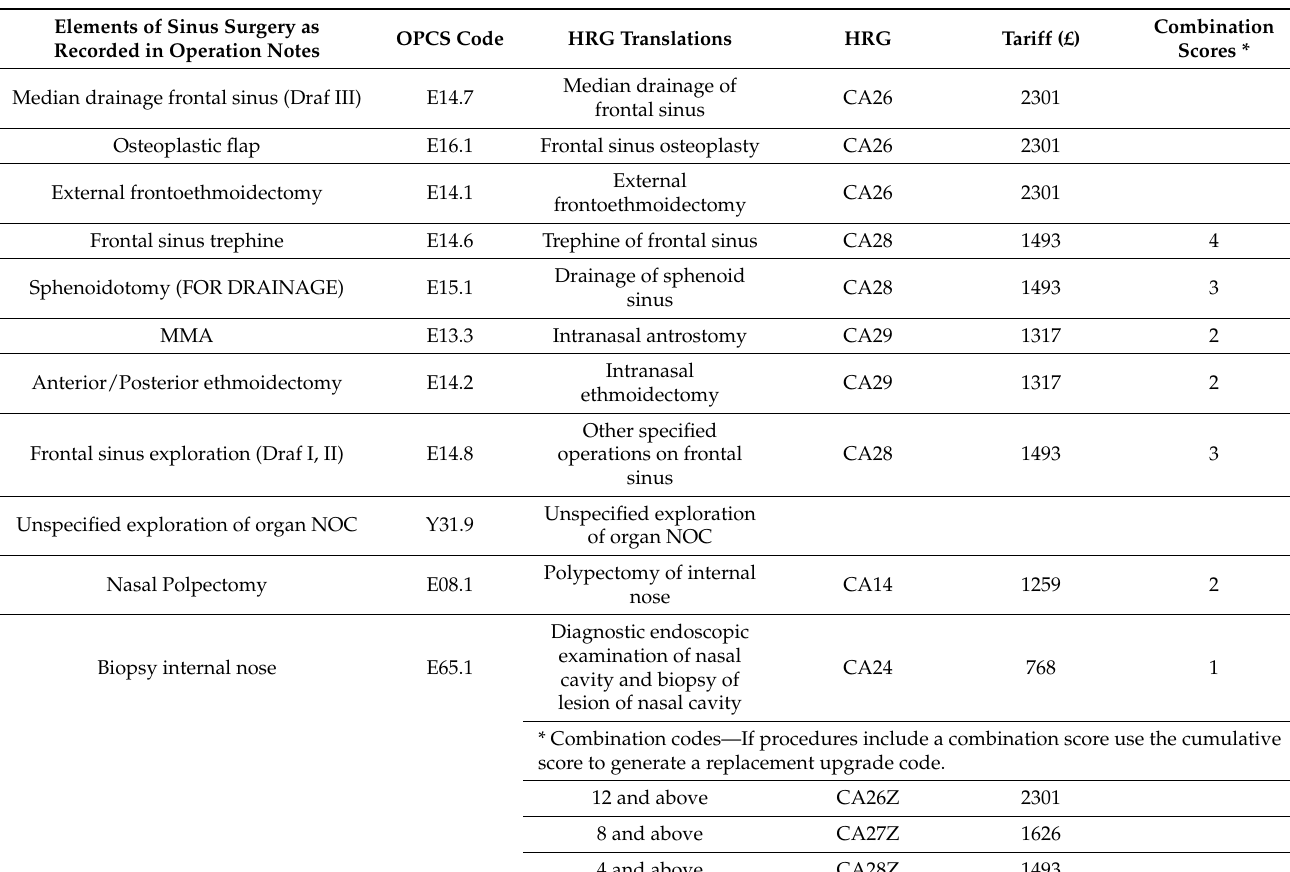
Table 1. Multidisciplinary coding standard (MCS) used to record SINUS SURGERY during the study (NB. Further add-ons and additional procedures with and without uplifts in code not included here for